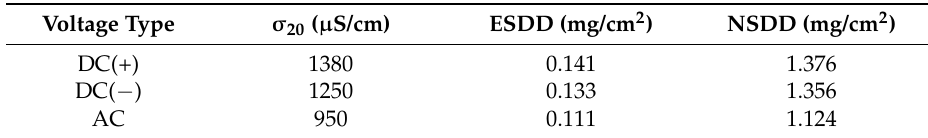
Table 5. The contamination